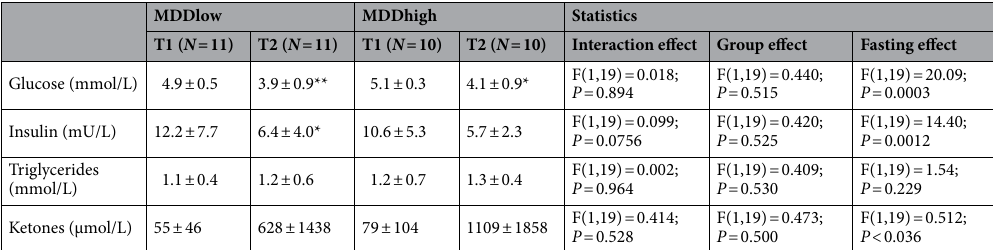
Table 2. Comparison of metabolic parameters in MDDlow in MDDhigh pre- and post-fasting. Table depicts mean values ± SD. RM two-way ANOVA was performed. Effect sizes for interaction and main effects are depicted. For post-hoc analyses, Sidak’s multiple comparison test was applied. ** P < 0.01, * P < 0.05 versus corresponding T1. P < 0.05 was considered to be statistically